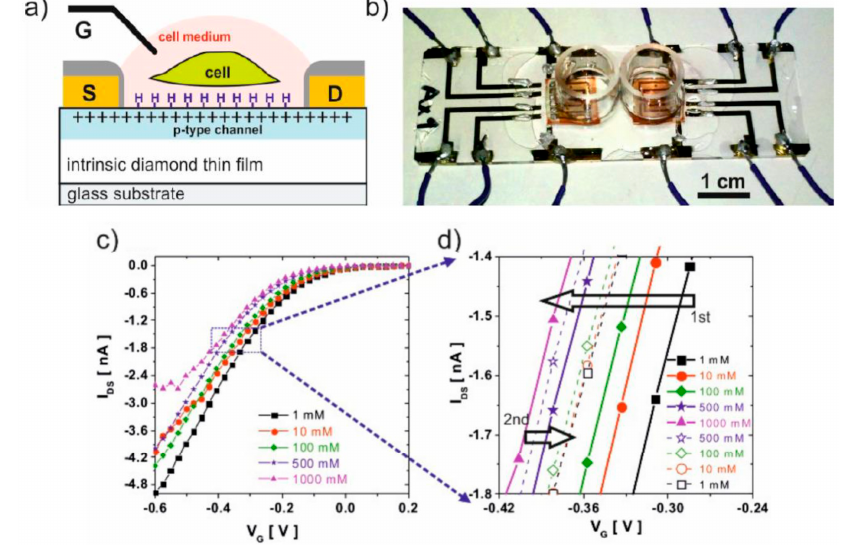
Figure 12. ( a ) Schematic view of the diamond-based electrolyte-gated FET (EGFET). Polarization of the gate/electrolyte interface creates a conductive p-channel in the intrinsic diamond semiconductor; ( b ) real device showing two wells above two sensors; and ( c , d ) transfer curves of the EGFET as a function of sodium concentration. Reproduced from Ižák et al. [74]. Copyright © 2017, with permission from Elsevier.